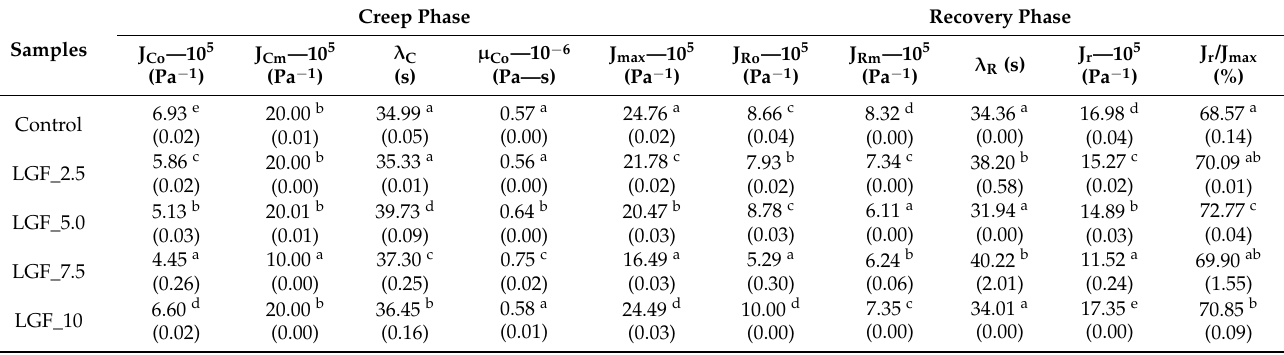
Table 1. Parameters of Burger’s